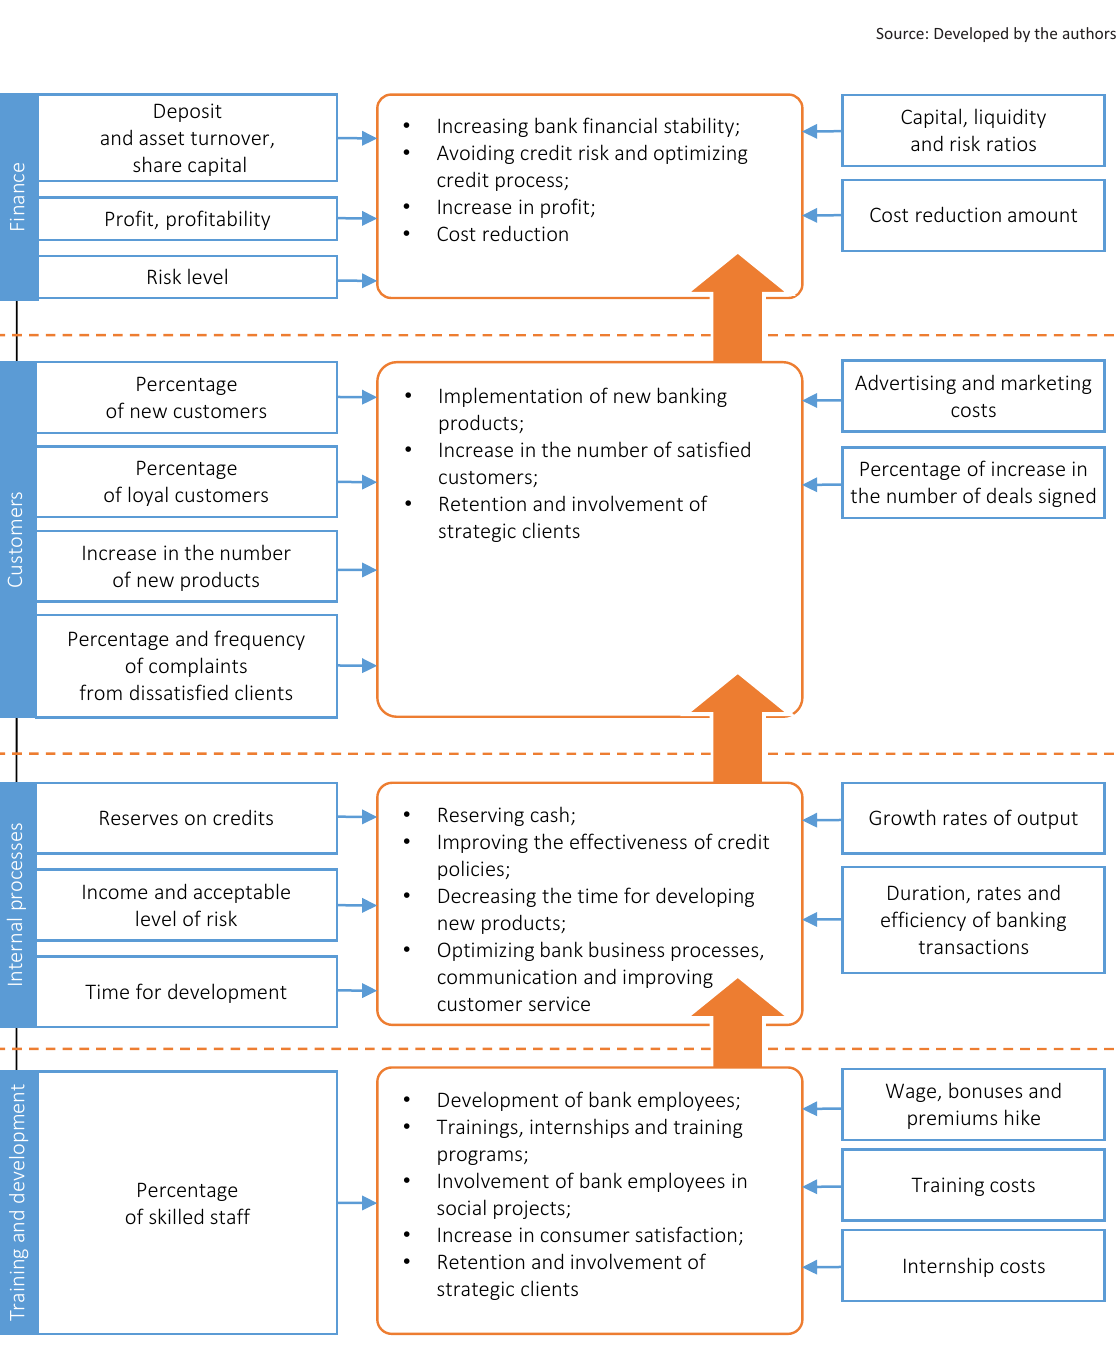
Figure 1. The strategy map of financial stability management at